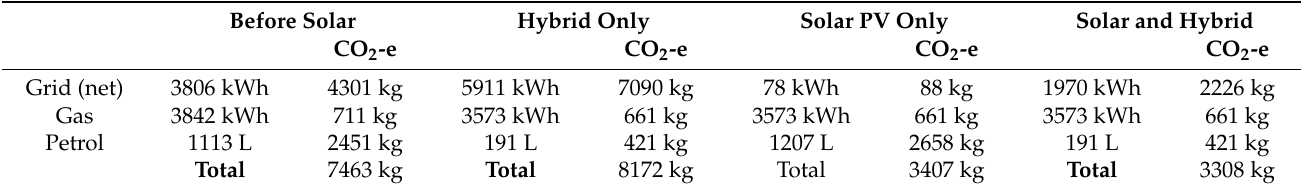
Table 3. Summary of CO 2 equivalent emissions (July 2013–June 2015).